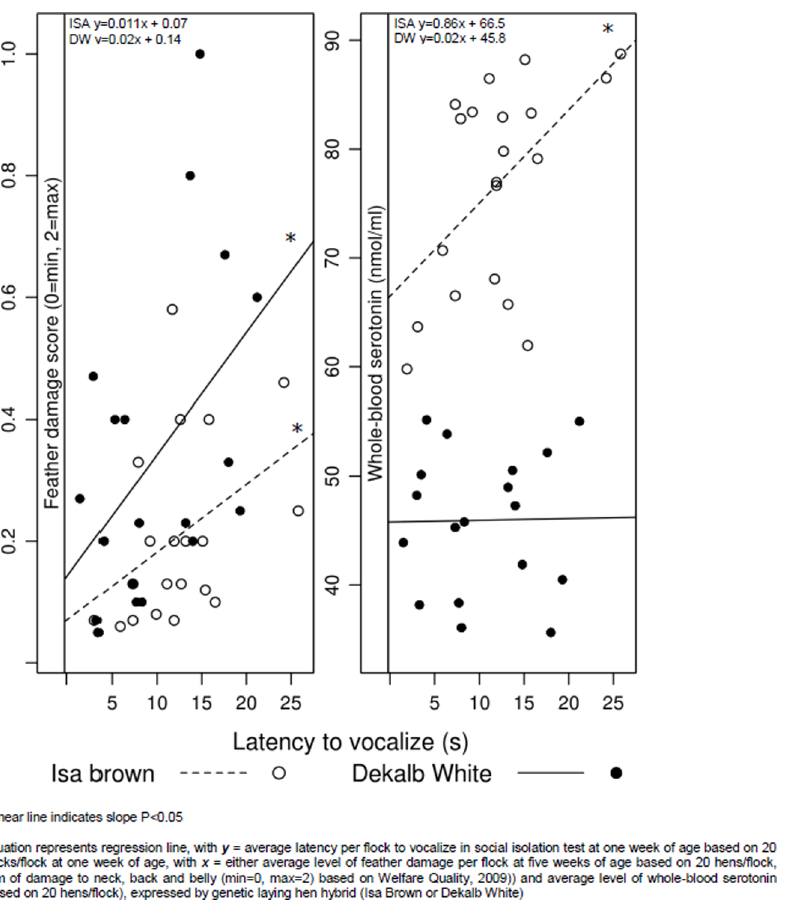
Figure 7. Average level of feather damage score at five weeks of age [left panel] and average level of whole-blood serotonin at 15 weeks of age [right panel] related to the average latency to vocalize in a social isolation at one week of age in flocks of Dekalb White (DW) and ISA Brown (ISA) laying hens.